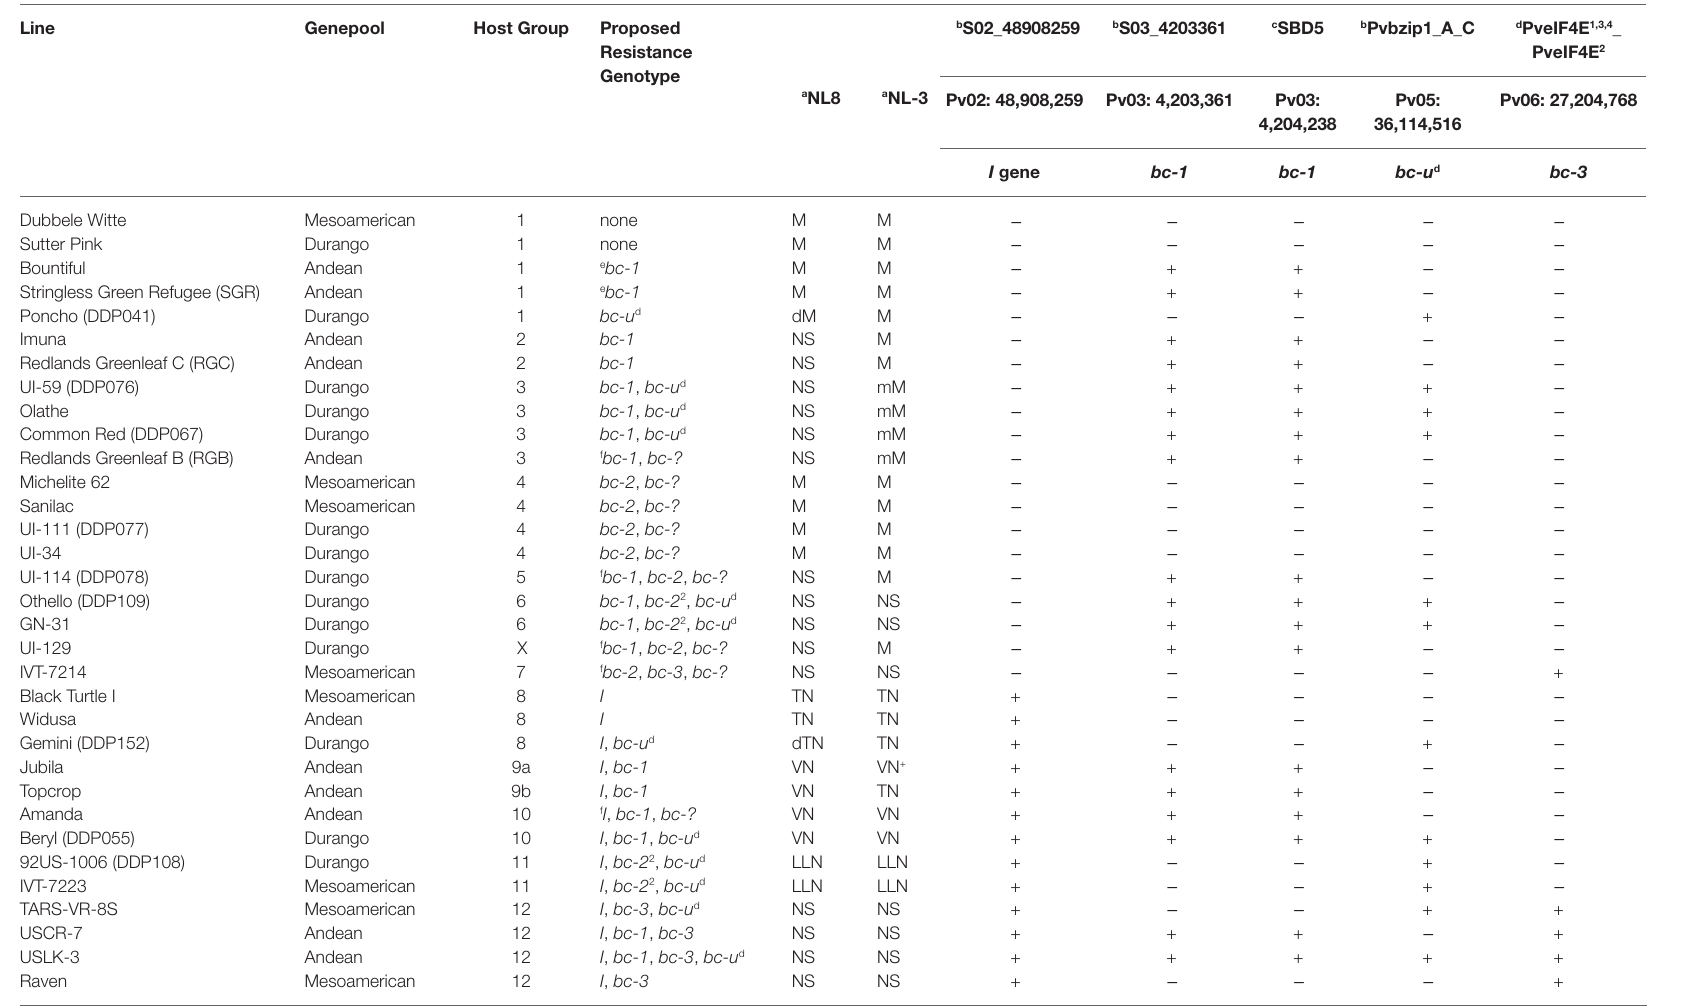
TABLE 5 | Single-nucleotide polymorphism genotyping of BCMNV and BCMV host differential genotypes.